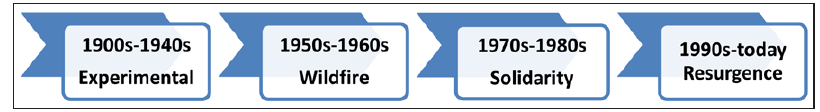
Figure 1: Periods in the evolution of community